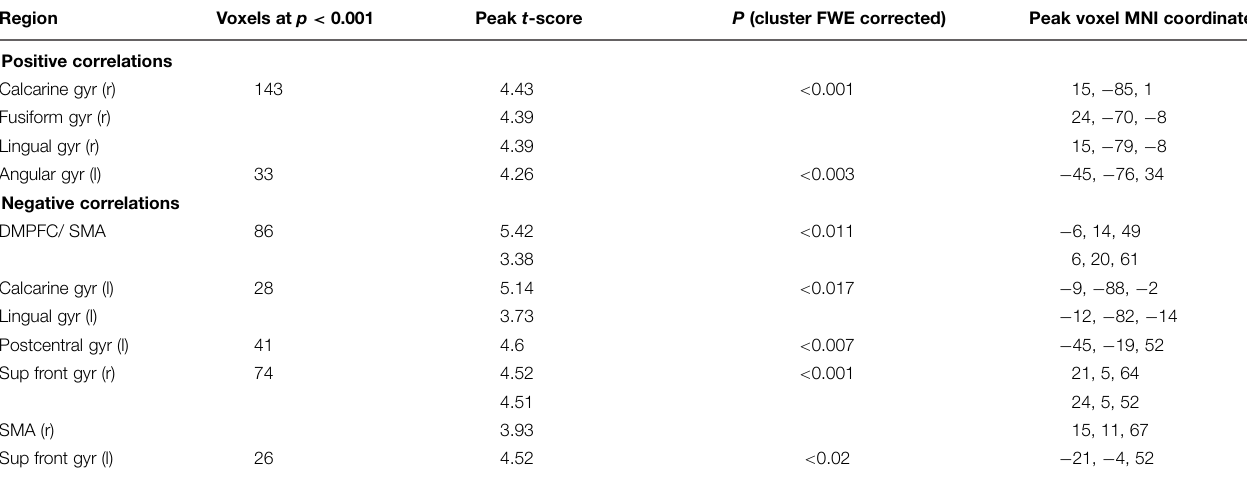
TABLE 5 | Conjunction: areas showing task-independent significant correlations with subjective certainty ratings in both color and motion trials. Region Voxels at p < 0.001 Peak t